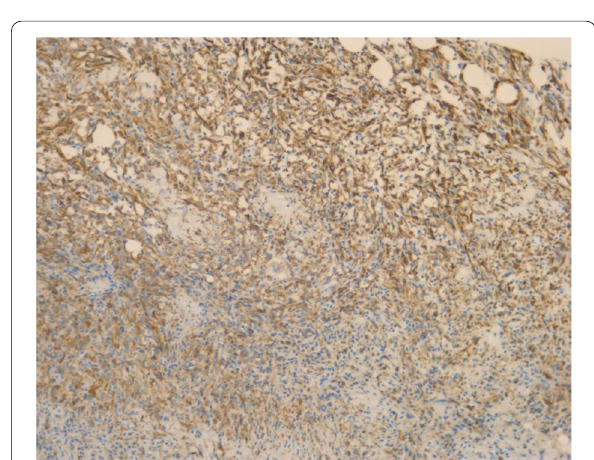
Fig. 4 Diffuse and strong membranous and cytoplasmic expression for Smooth muscle actin (SMA)